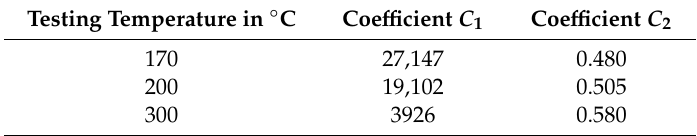
Table 1. Determined coefficients for the corresponding testing temperature.